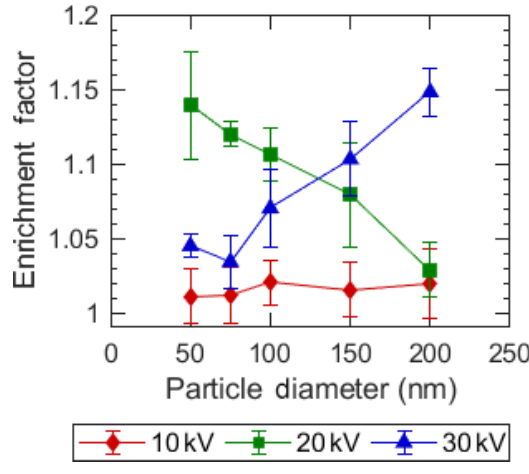
Figure 6. Observed aerosol enrichment at varying voltages and par- ticle